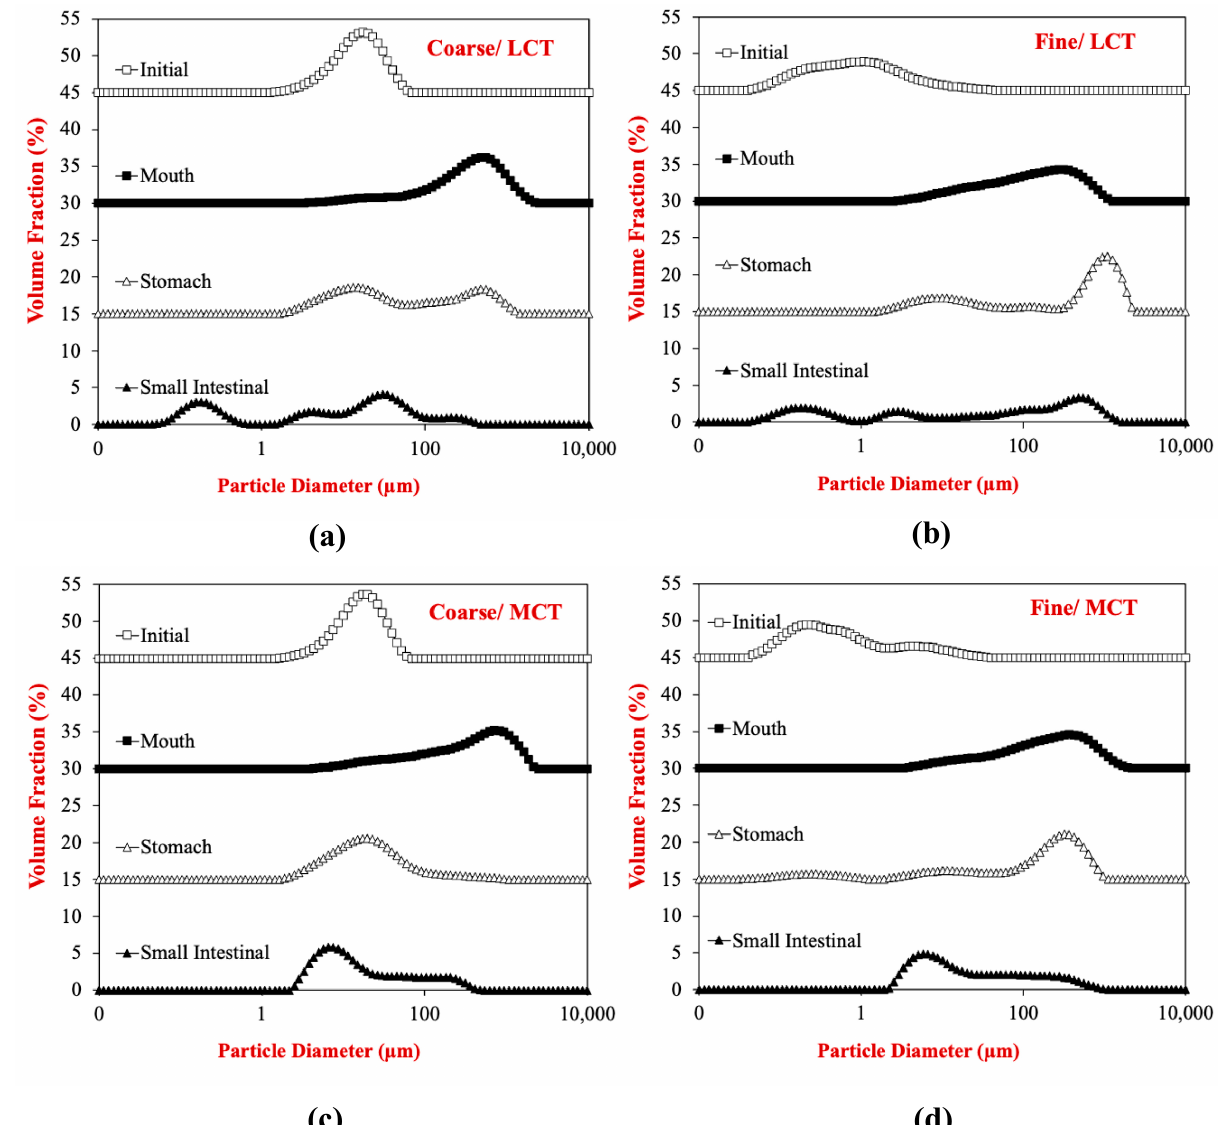
Figure 2. Impact of oil type (LCT or MCT) and droplet size on the particle size distributions (Coarse or fine) of egg analogs after exposure to different stages of a simulated gastrointestinal tract: Coarse/LCTs ( a ); Coarse/MCTs ( b ); Fine/LCTs ( c ); Fine/MCTs ( d ). LCT: long chain triglycerides. MCT: medium chain triglycerides. LCT: long chain triglycerides. MCT: medium chain triglycerides.